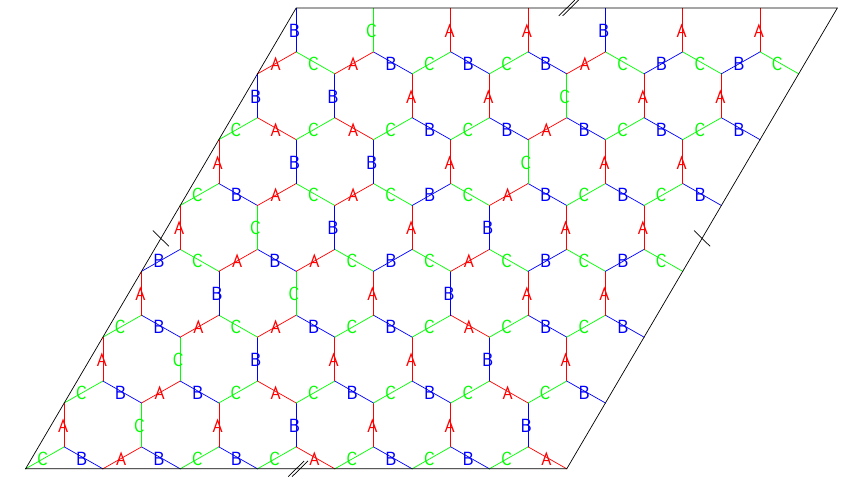
Figure 1: Example of a 3-coloring of a hexagonal lattice, with periodic boundary conditions (torus geometry).